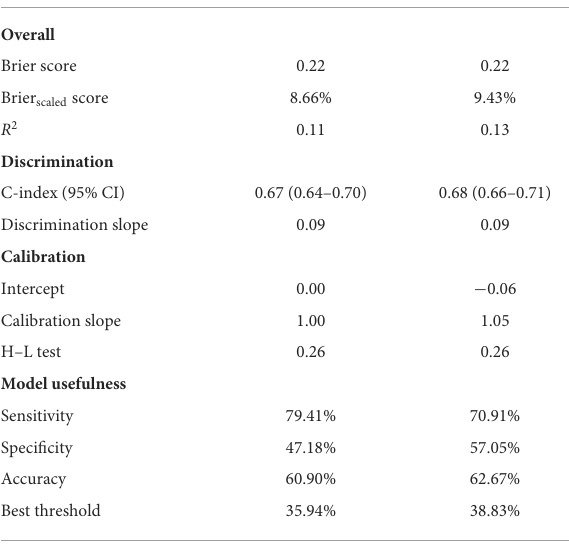
TABLE 4 Effectiveness of the model to predict probability of hospital administrators encountered medical disputes at